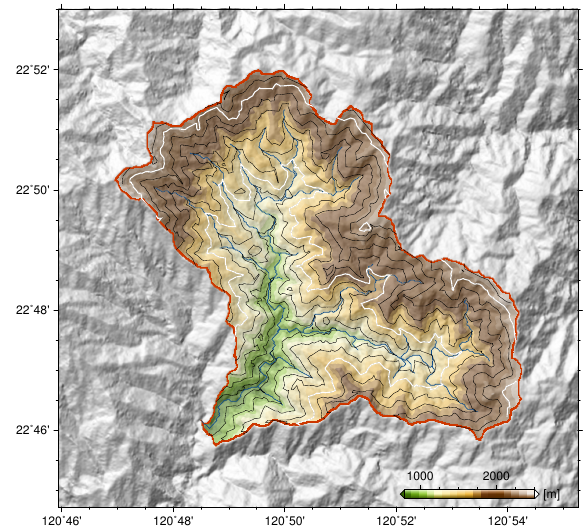
Figure 6. Map of elevation (coded by color) and χ θb values (con- tour lines) of the catchment considered in Fig. 5. The contour line interval is 0 . 5km, and the lines of χ θb = 2 . 5km and χ θb = 5km are emphasized in white.